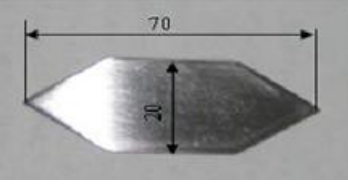
Figure 1. Stainless steel template insert of the gravitational field flow fractionation device.